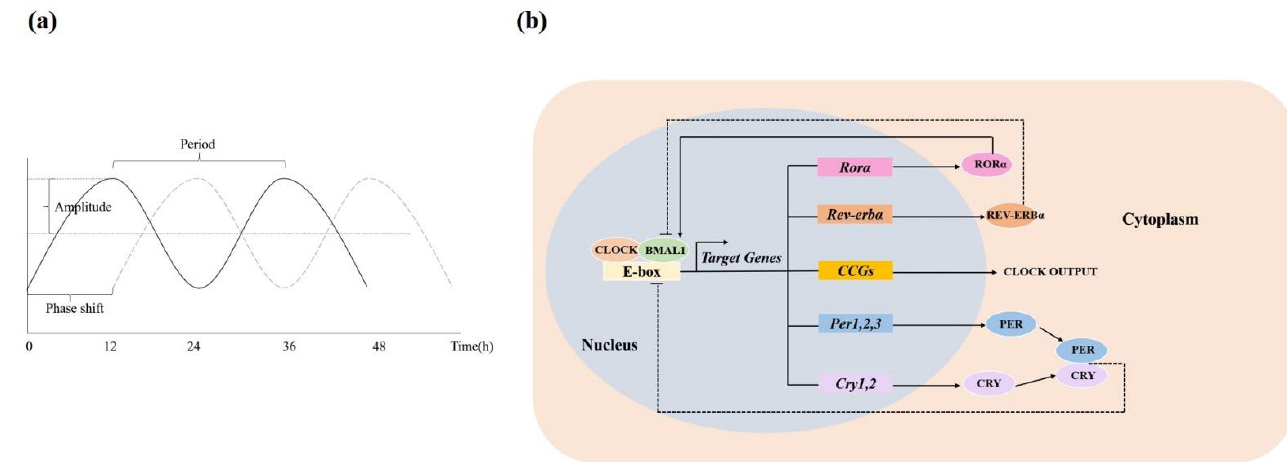
Figure 1. Molecular mechanism of the circadian clock. ( a ) The three parameters (amplitude, phase and period) of circadian rhythmicity. ( b ) In the TTFL, the positive transcriptional limb CLOCK and BMAL1 drive the expression of negative feedback repressors (PER, CRY), which subsequently suppress the expression of the positive limb. Additional feedback loops include REV-ERBα and RORα. REV-ERBα stimulates the gene expression of Bmal1, while RORα inhibits Bmal1 gene expression. CLOCK and BMAL1 also regulate a variety of clock-controlled genes (Ccg) that mediate the downstream circadian clock output. (In Figure 1b, straight lines: stimulation; dashed lines: inhibition.).